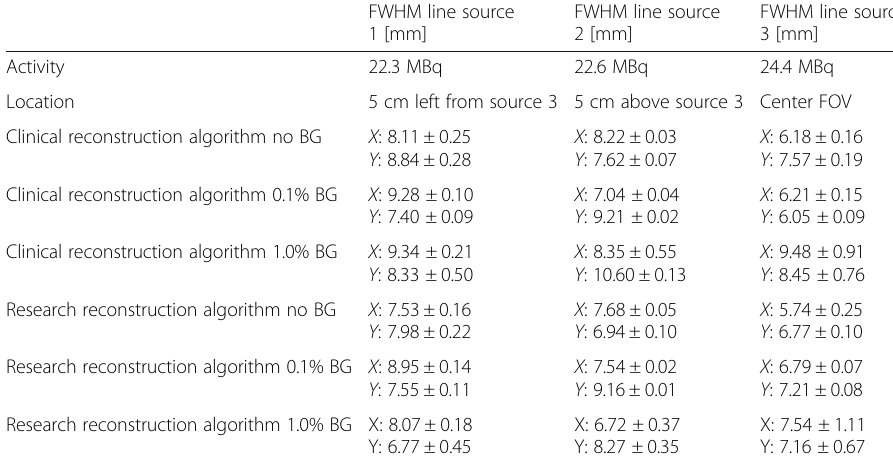
Clinical reconstruction algorithm 0.1% BG Clinical reconstruction algorithm 1.0% BG Research reconstruction algorithm no